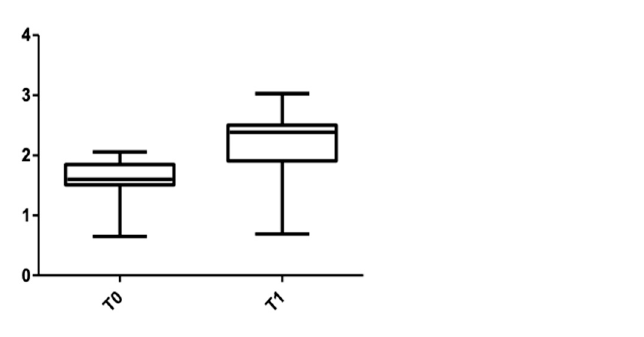
Figure 6. CBCT values at the cervical level, upper arch, at T0 and T1 for males.